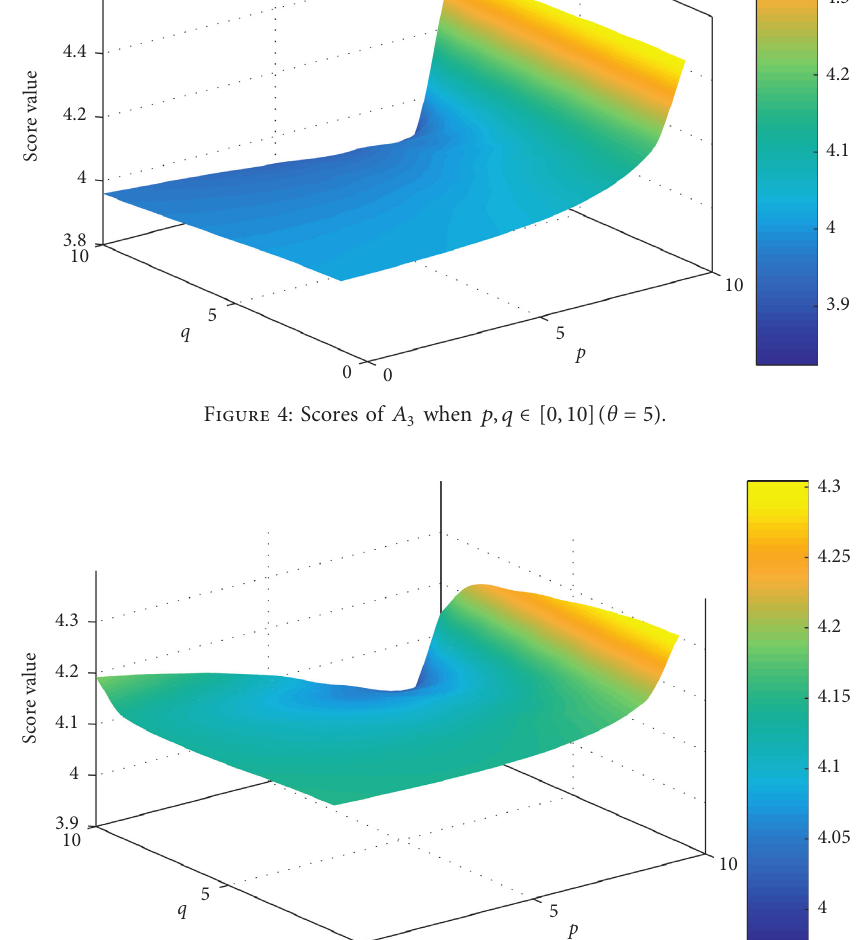
when p,q ∈ [ 0 , 10 ]( θ � 5 ) 4